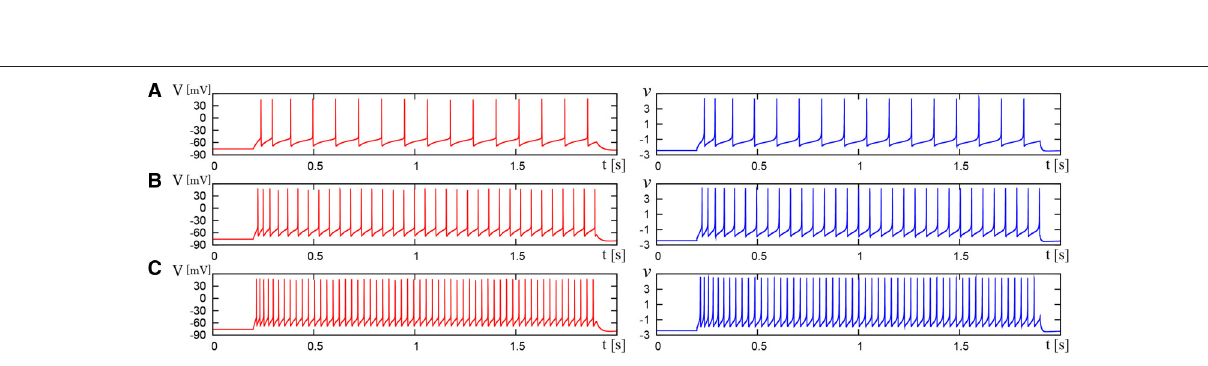
Frontiers in Neuroscience | www.frontiersin.org